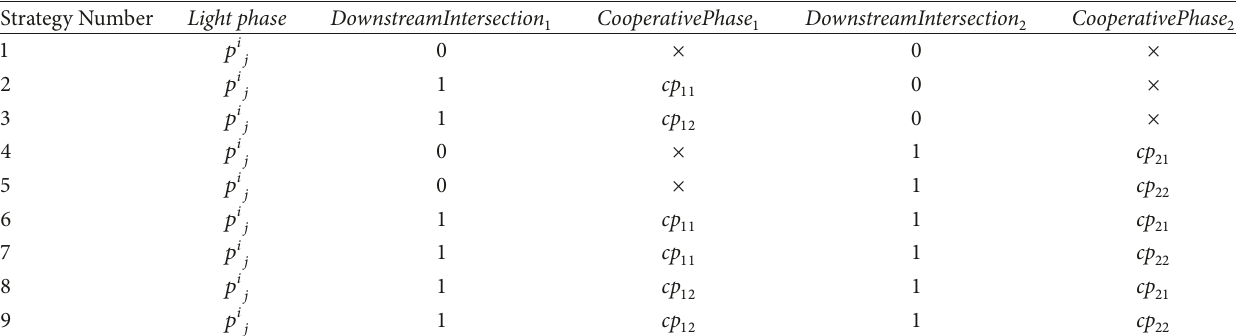
Table 1: The possible cooperative phase switching strategies of 𝑝 𝑖 𝑗